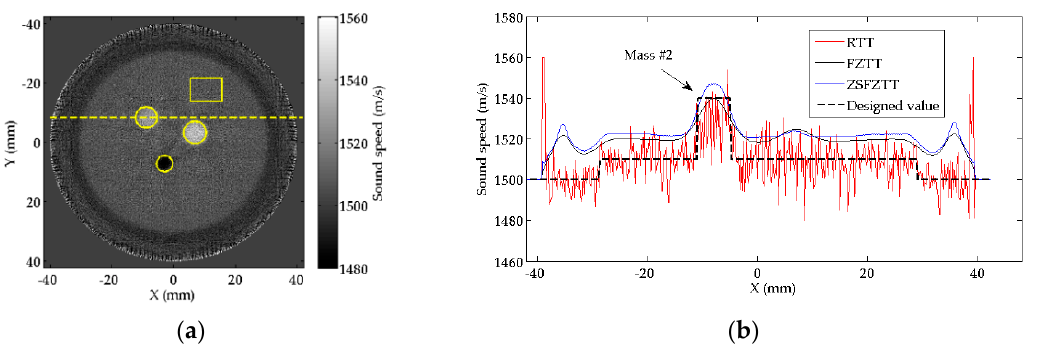
Figure 7. ( a ) The horizontal central line (the dashed line) to be measured in Mass #2 and area of interest (AOI) selection (the circles and the rectangle) for measurements; ( b ) the profiles of SS values on the horizontal central line of Mass #2. Table 2. The Bias size measured on SS image of numerical phantom reconstructed by RTT, FZTT, and ZSFZTT methods.